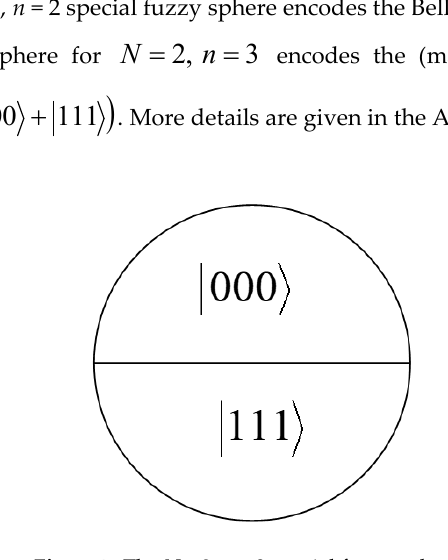
Figure 7. The N = 2, n = 3 special fuzzy